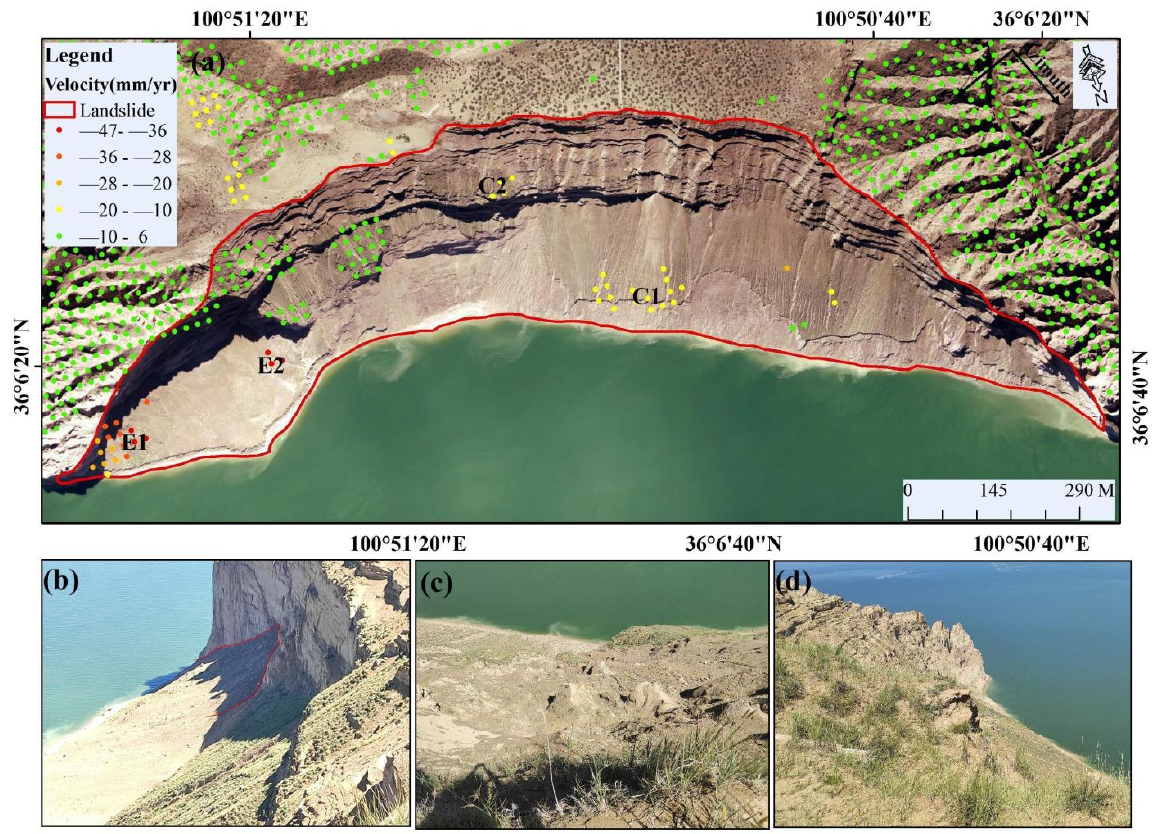
Figure 11. ( a ) Deformation velocity of the Chana landslide. ( b ) A small landslide on the eastern side, ( c ) collapse position and scattered rocks in the central part, and ( d ) isolated soil blocks on the western side.